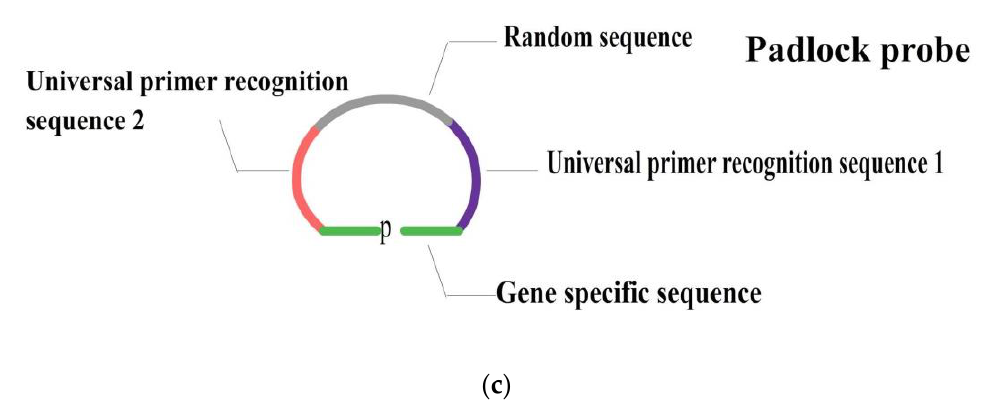
Figure 1. Schematic illustration of MHRCA-MPND. ( a ) When the target gene exists, the padlock probes is linked into a loop, and it is amplified with the universal primer by a hyperbranched rolling circle amplification. The product is irreversibly agglomerated with magnetic particles, and the detection result is visible to the naked eye. ( b ) When the target gene non-exists, the linking reaction and amplification reaction are not carried out, no HRCA product is entangled with the magnetic particles and the magnetic particles are re-suspended in the solution. ( c ) Padlock probe structure.